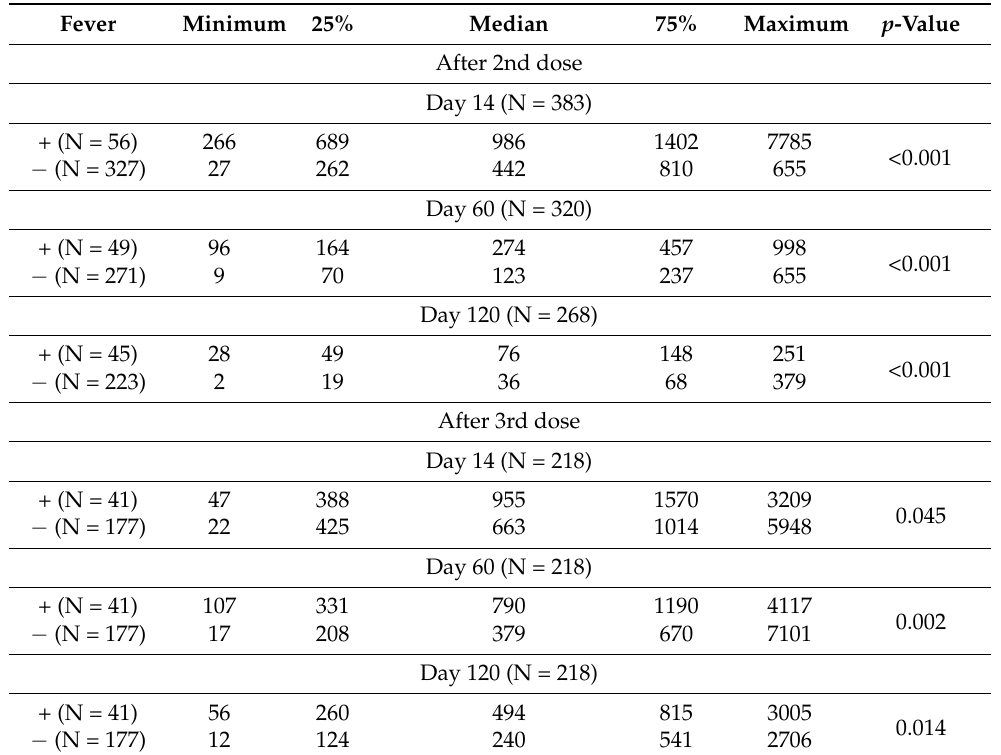
Table 2. Changes in serum SARS-CoV-2 spike Ig levels on Days 14, 60 and 120 after the 2nd and 3rd vaccination, depending on whether fever occurred within 7 days after the vaccination. Number of patients with fever (N,%) after 3rd dose: 41/218 (19%).